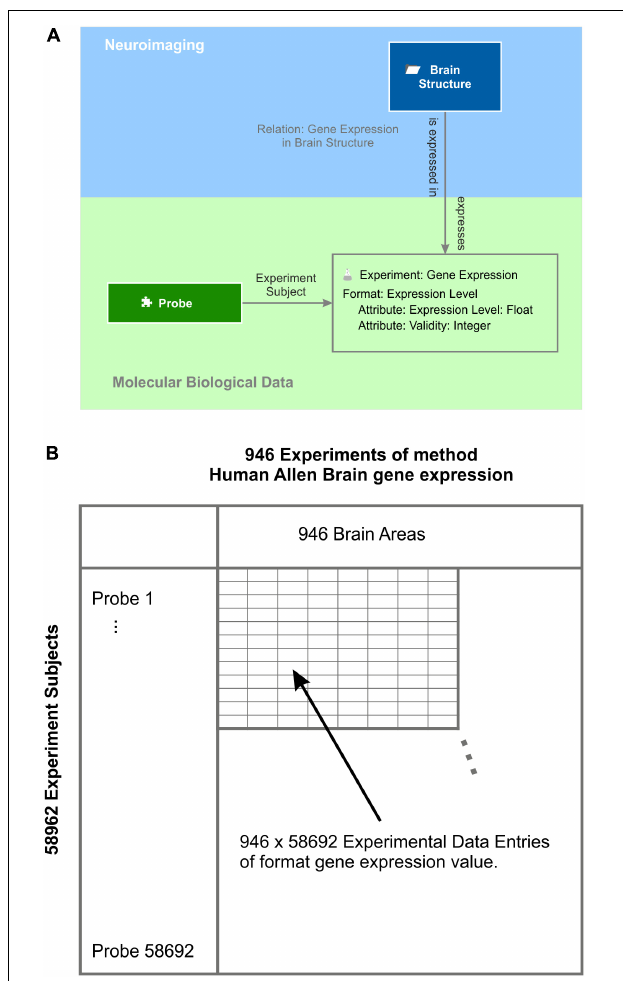
FIGURE 7 | Gene expression experiments. (A) Experiments of method “gene expression” have the expression level format. They contain the actual value and a validity signal provided by the Allen Human Brain Atlas (Hawrylycz et al., 2012). Each experiment contains the gene expression values measured by all probes and relates to the respective “brain structure” element by the semantic relation “gene expression in brain structure.” The probe is the subject of each gene expression experiment. (B) Subject and experiment name expand a table with the subjects being the row labels and the experiment names being the column labels. In this example, the probes label the rows and the brain areas the columns. This table holds all data that is stored by the experiment method gene expression – in this case, 946 × 58692 experimental data entries taken from one post-mortem brain (Hawrylycz et al.,